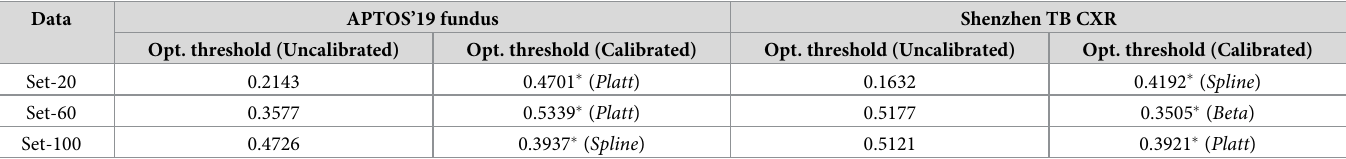
Table 5. Optimal threshold values identified from the PR curves using uncalibrated and calibrated probabilities (using the best-performing calibration method for the respective datasets).